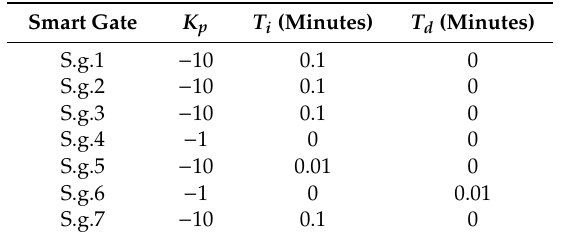
Table 3. Proportional–integral–derivative controller (PID) constants set in SWMM 5.1 as control rules for the Fossolo network